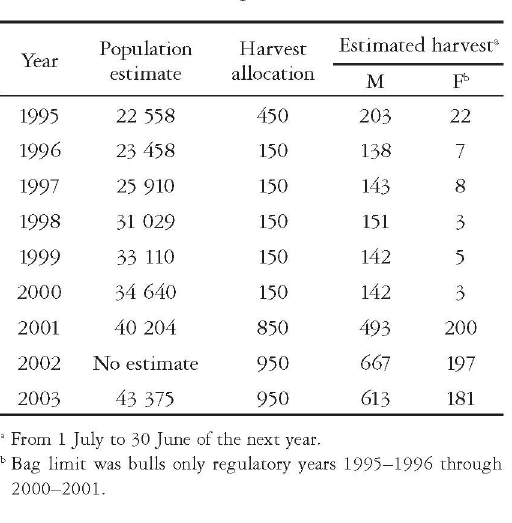
Table 1. Fortymile caribou population estimates, harvest allocations and reported harvest,